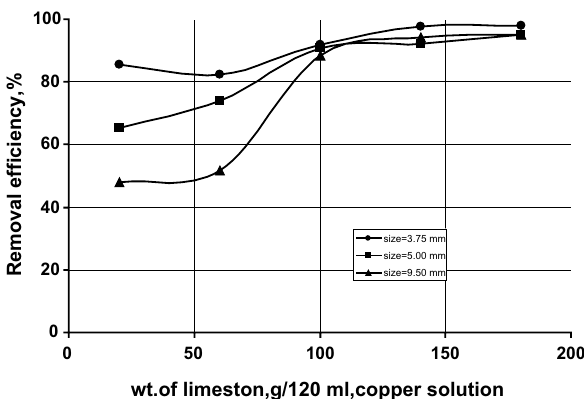
Fig. 1 The effect of volume of limestone on removal efficiency of copper for high influent concentration of copper (7.04 mg/l)